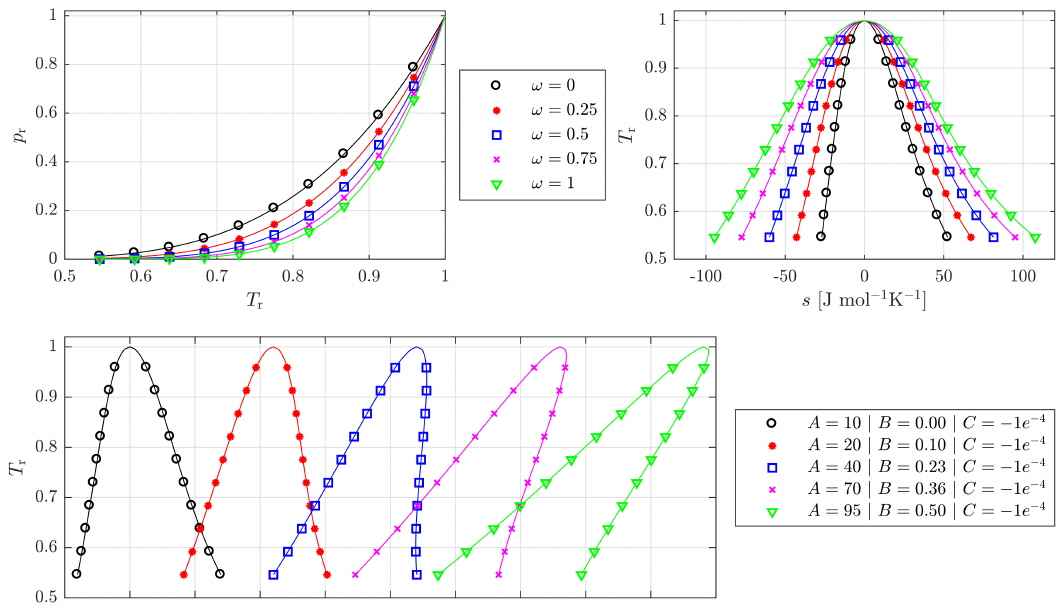
Figure 1. Effect of ω , A , B and C on the thermodynamic behaviour of a working fluid with T cr = 500 K and p cr = 30 bar. For the top two plots, A = B = C = 0, whilst for the bottom plot ω =